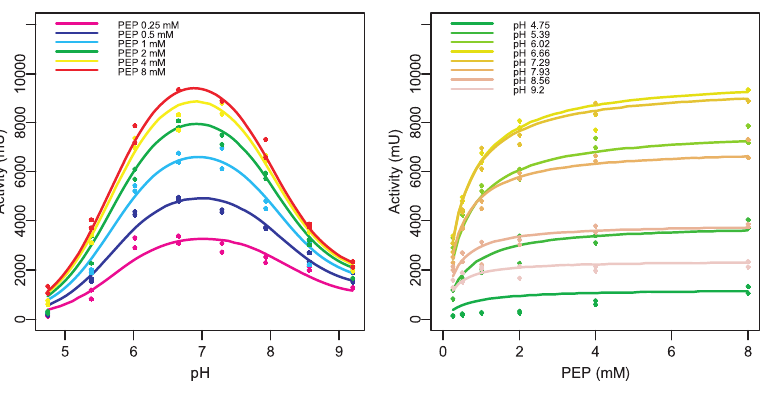
Figure 5. Dependence of PYK activity on pH and PEP concentration. In graph a), each colour corresponds to a slice through the parameter space with a fixed PEP concentration, in graph b), each colour corresponds to a slice with a fixed pH value. The dots represent measured data, the straight lines show the predictions of the diprotic model fitted to the data. The measured data indicates a shift of the pH optimum towards more acidic pH values at low substrate concentrations, but the fitted model does not show this shift.